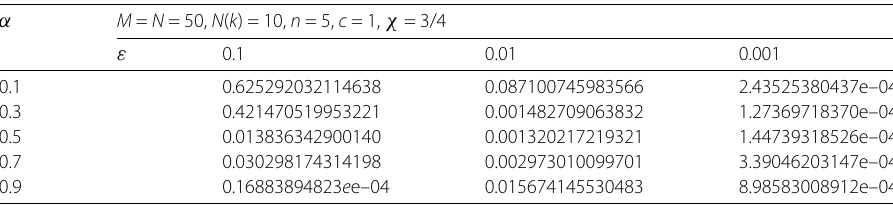
Table 1 The error estimation between the exact and regularized source functions for α ∈ { 0.1,0.3,0.5,0.7,0.9 } and x ∈ (0, π ) α